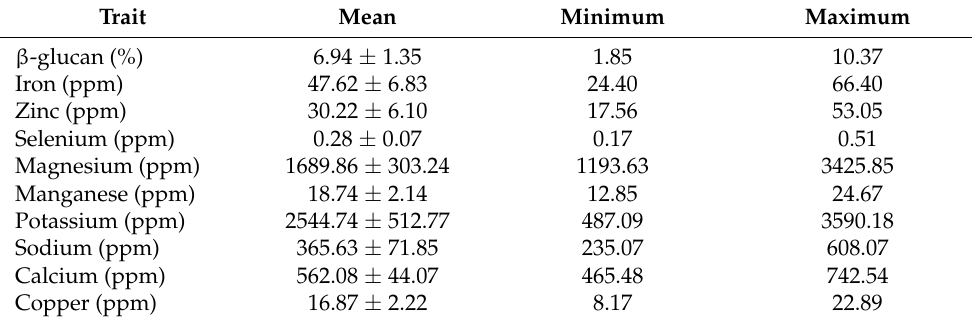
Table 3. Mean, standard deviation and range of β -glucan and microelement contents in the flour of Hordeum spontaneum bulk accessions harvested from Marchouch during 2016_17 and 2017_18 seasons.